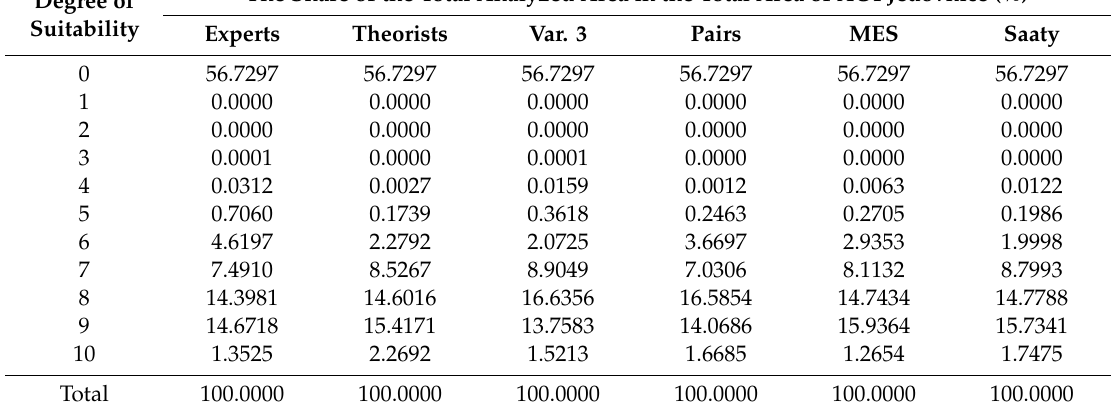
Table 3. Percentage share of the sizes of selected areas of the same suitability value in individual variants on the total size of the area of